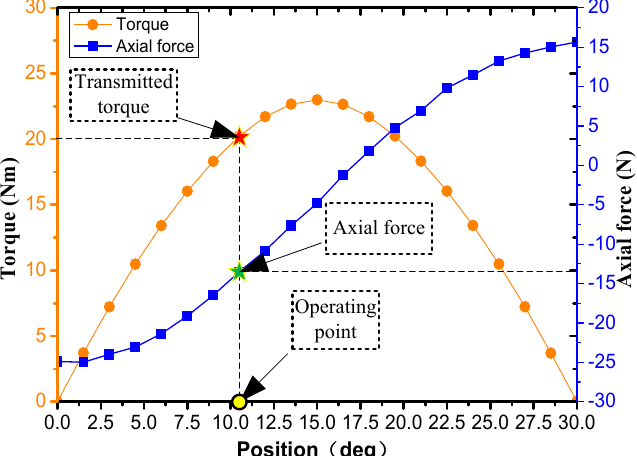
Figure 12. Axial force and transmitted torque of the C-HPMC with 1 mm axial displacement.